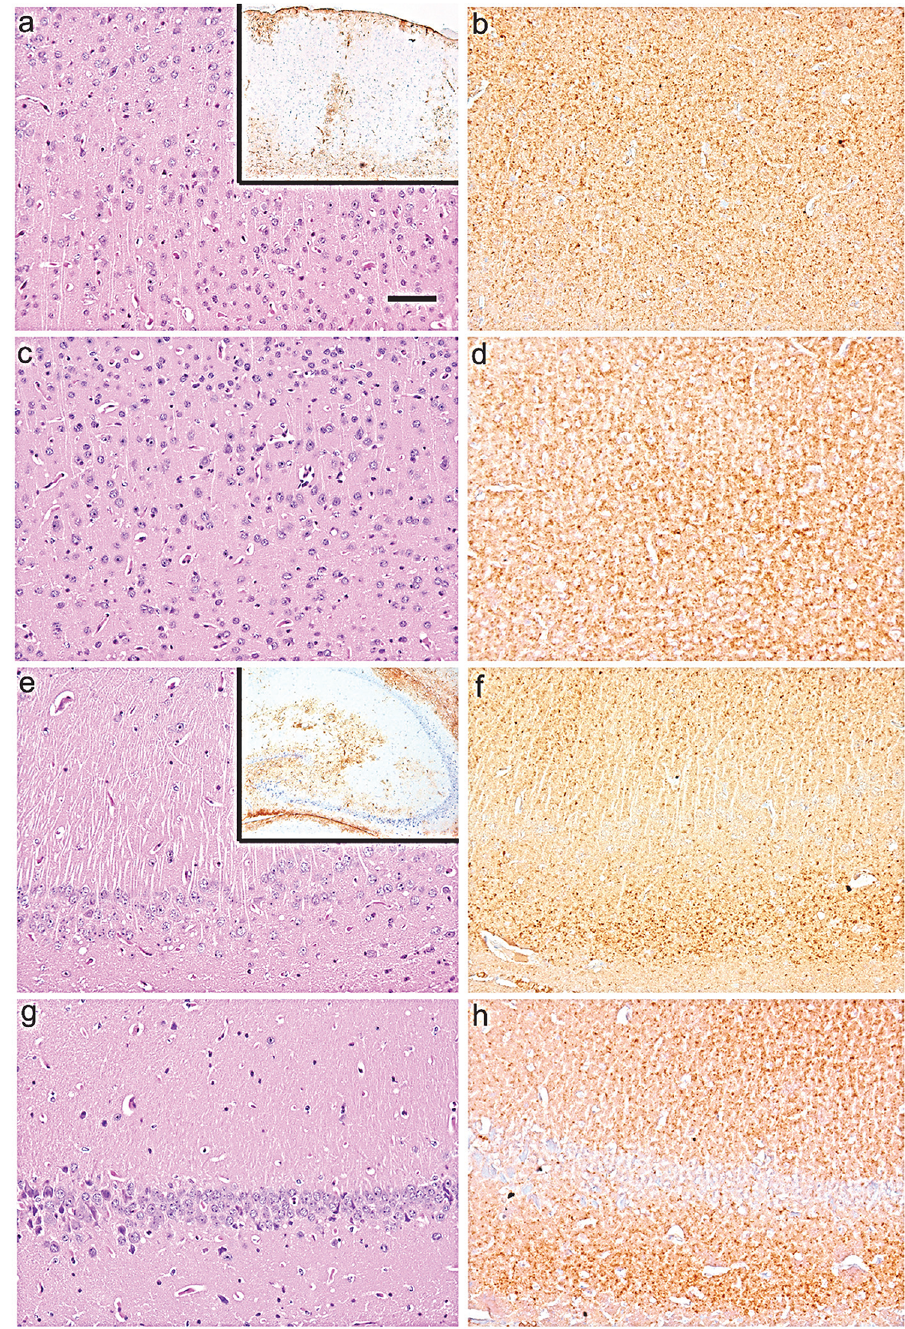
Fig 3. Histopathological analysis of brains from the 1 st passage of dgPMCAb-derived PrPres. Representative images of the frontal cortex ( a, b, c, d ) and hippocampus ( e, f, g, h ) of animalsinoculated with dgPMCAbproducts seededwith fibrillarWT α -synuclein ( a,b,e,f ) or dgPMCAbproducts seededwith lysates of HeLa cells expressingA30P α -synuclein( c,d,g,h ). Note the lack of spongiform changein the sections stainedwith hematoxylin and eosin ( a, c, e, g ) and patchy reactive astrogliosis(immunostaining for GFAP are in the insets in panels a and c ). Immunostaining for PrP using SAF-84 ( b, d, f, h ) revealeddiffuse/synaptic and granulardeposits. Scale bar in a = 50 μ